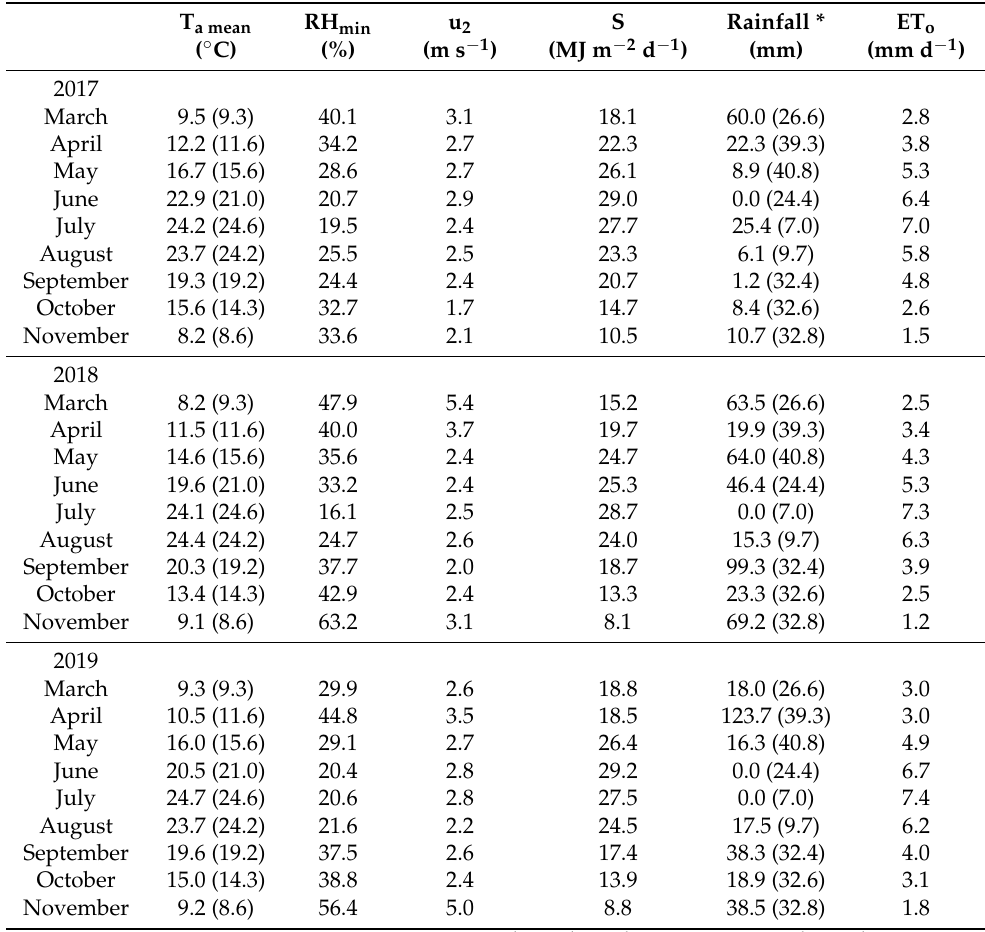
Table 1. Almond growing season monthly meteorological means or totals for the experimental period (2017–2019), and 30-year means of T a mean and rainfall in